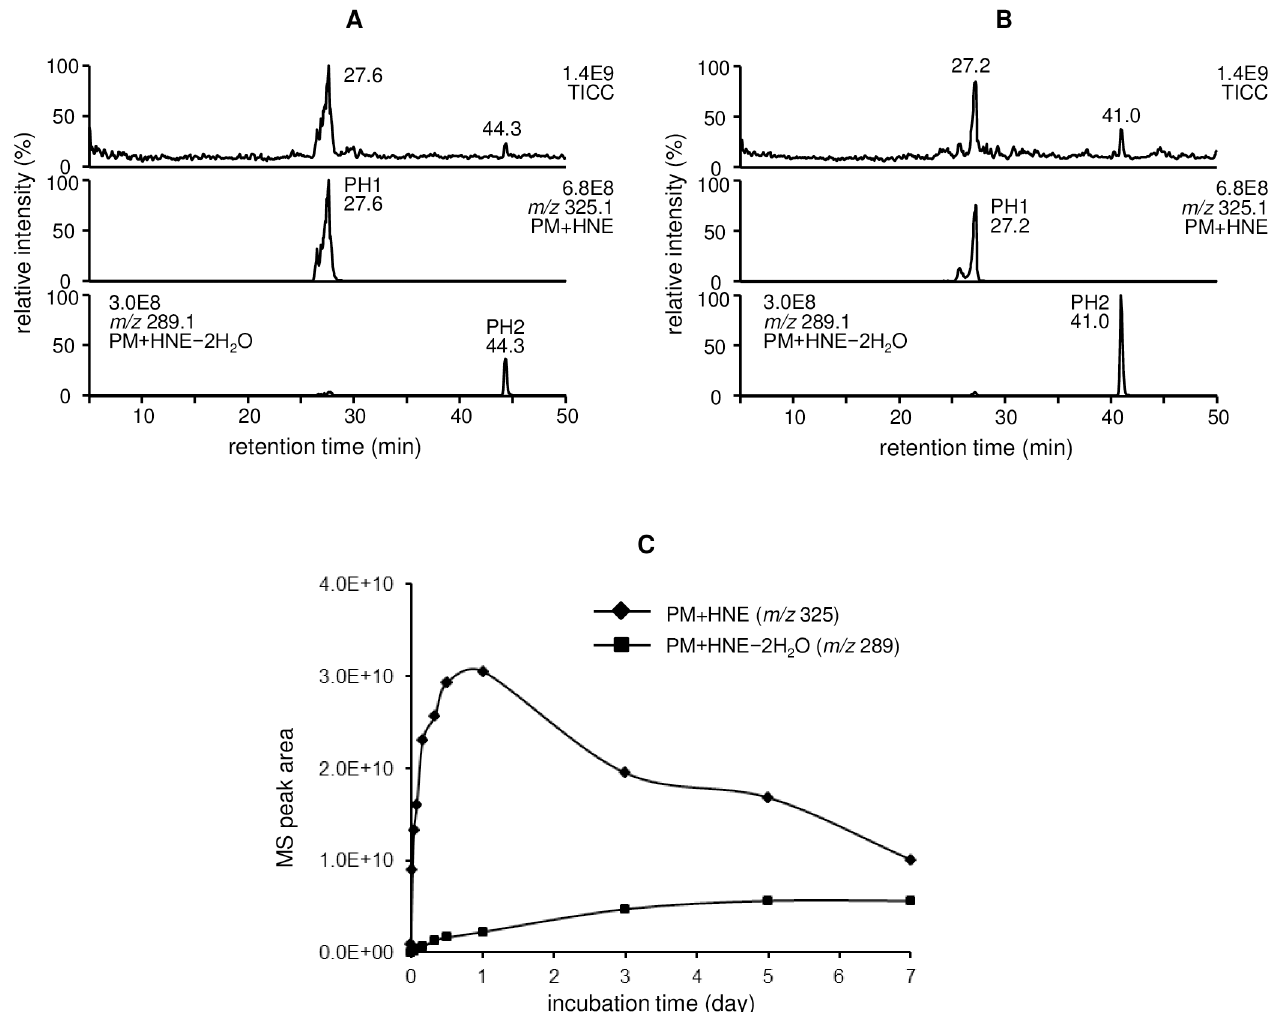
Fig 3. LC/ESI-MS analysis of the reaction between PM and HNE at 37 ˚C for (A) 24 h and (B) 5 days. (C) Formation of PM-HNE adducts in 7 days.